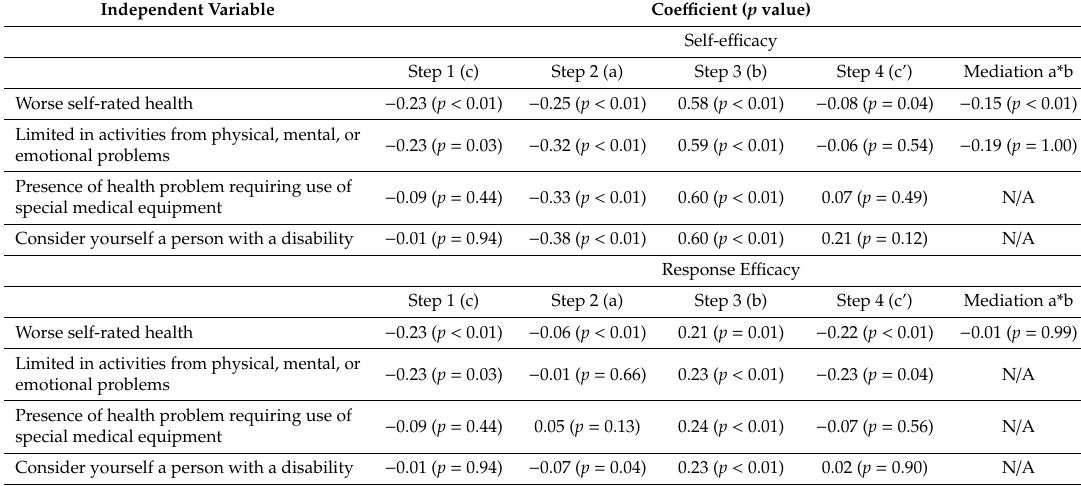
Table 2. Mediation analysis of self-e ffi cacy and response e ffi cacy on the relationship between disability and disaster preparedness, Los Angeles County, 2013 ( n = 4700) a .